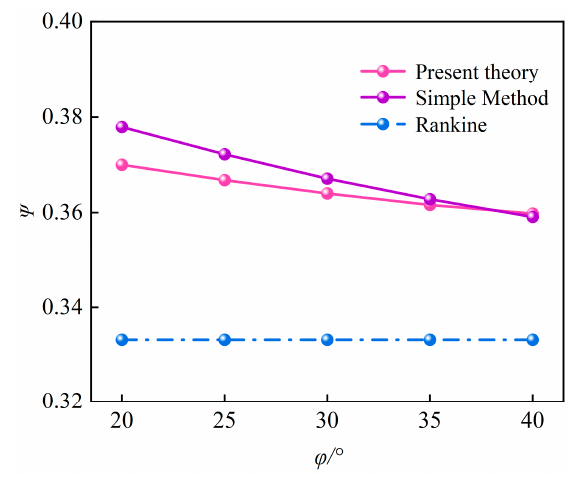
Figure 24. Relation curves of ψ and δ .